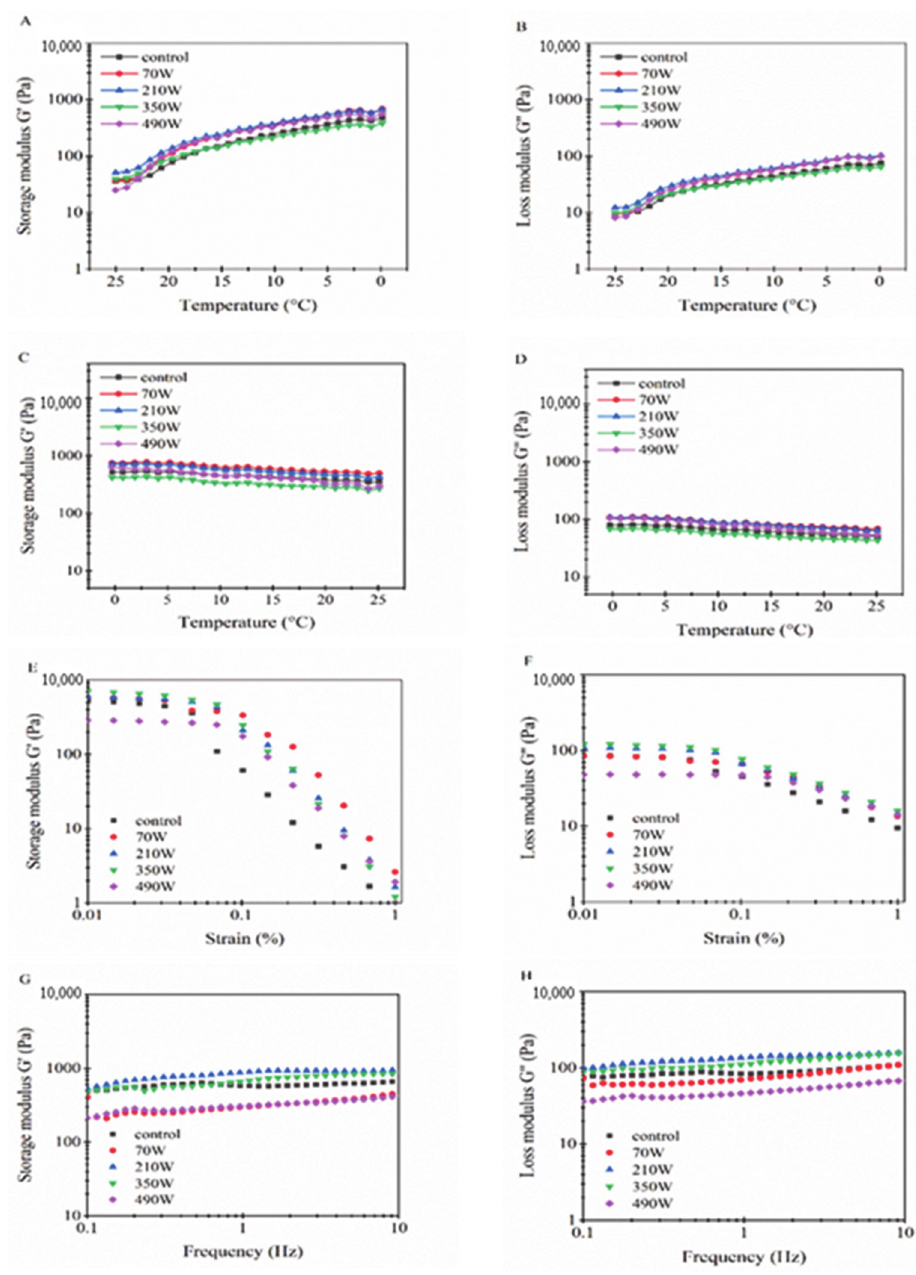
Figure 4 . Effect of microwave power on G ′ and G ′′ of the lysozyme ‐ oregano essential oil (LZ ‐ OEO) bacteriostatic gels during colling scanning ( A , B ), heat scanning ( C , D ), strain scanning ( E , F ) and frequency scanning ( G , H ) .